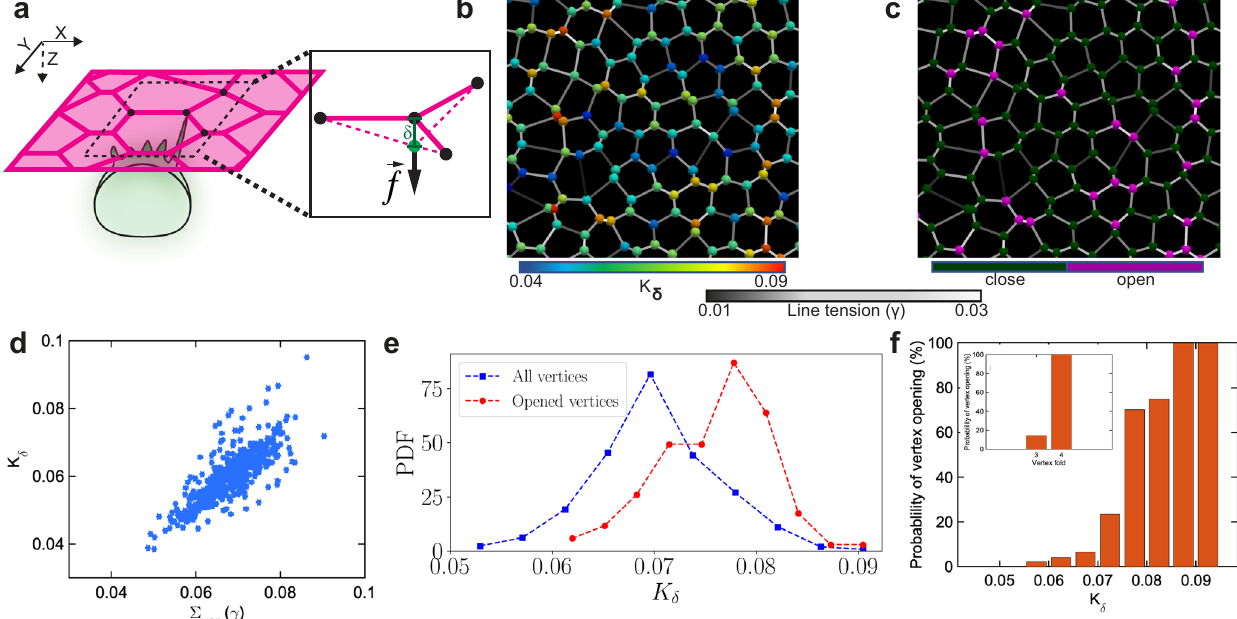
Fig.3|Vertexmodelpredictsthatverticeswithhigher-foldandnetlinetension providepreferredspotsfor MCCintegration. a Schematicsrepresentthe out-of- plane force ( f ) exerted by an integrating MCC on an epithelial vertex inducing an out-of-plane displacement ( δ ). b Representative snapshot of the simulated cellular network.Thecolormaponjunctionsindicateslinetension( γ ),whiletheverticesare color-coded according to their stiffness ( K δ ). c Representative snapshot of the cellular network illustrating propensity of vertices to open upon cell